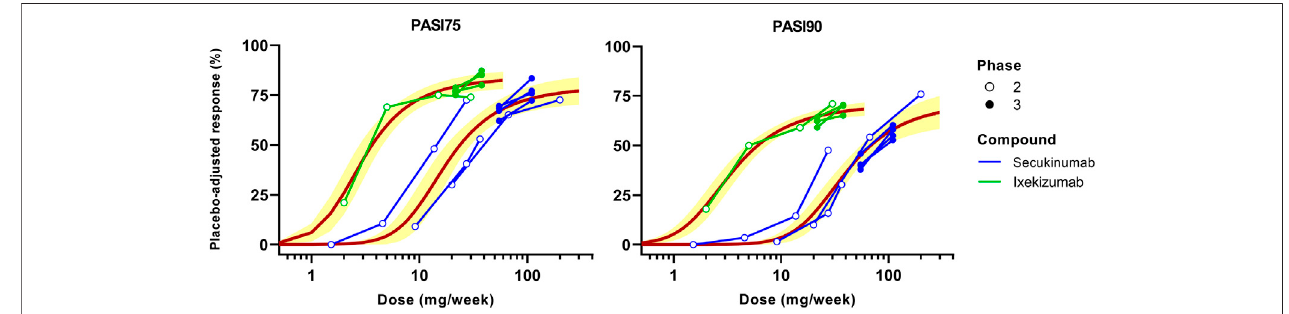
FIGURE 2 | Dose-based model-based meta-analysis (MBMA) of clinical trial results for secukinumab and ixekizumab. Average dose (mg/week) was calculated based on total administered dose over 12 weeks. Clinical response 12 weeks after the initial dose was used as ef fi cacy endpoint. Solid lines represent model- fi tted trendline, whereas symbols indicate observed mean data. The observed mean data from individual clinical studies are connected. Shaded bands depict the 95% CI around the regression